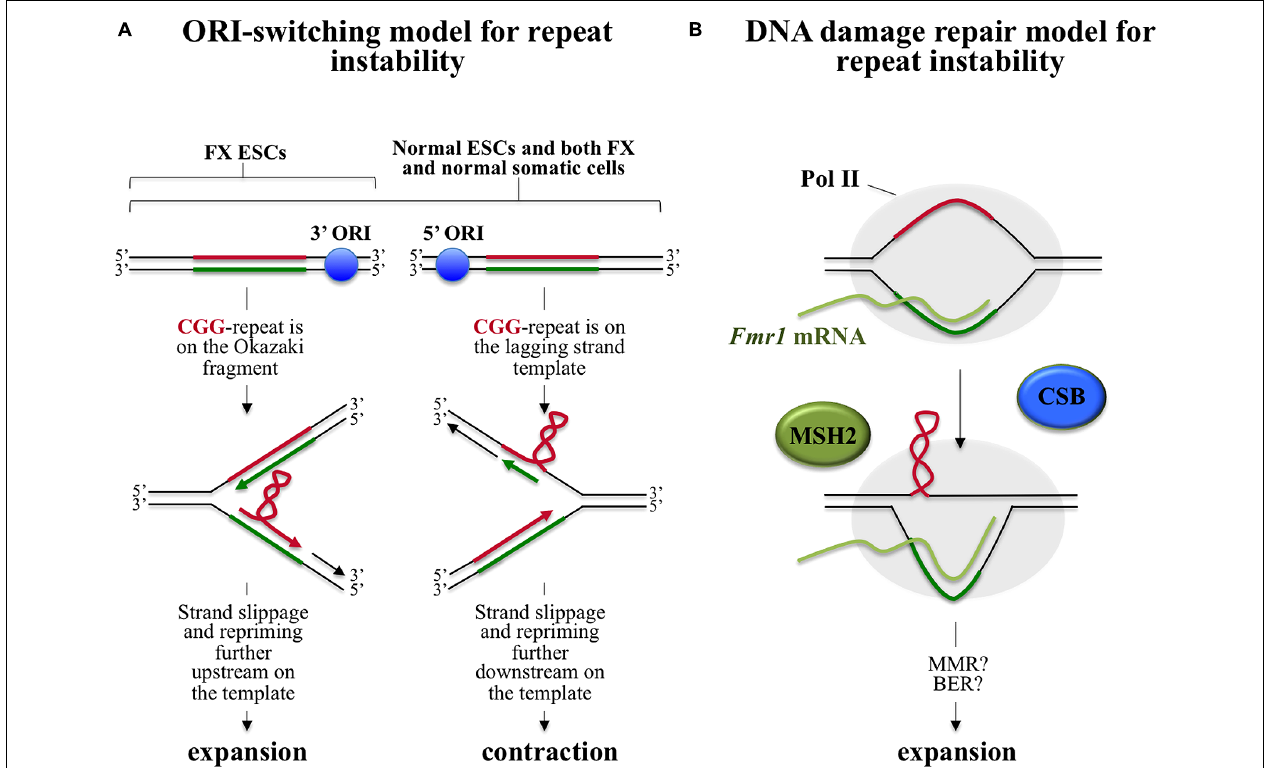
FIGURE 1 | Models for intergenerational repeat instability at the FX locus. In both models the CGG-rich strand, which forms the most stable secondary structure, is shown in red and the CCG-rich strand is shown in green. (A) ORI-switch model for FX repeat instability. The FMR1 gene is flanked by two ORIs, one located 45 kb upstream (5 (cid:2) ) and another 45 kb downstream (3 (cid:2) ) of the gene (Gerhardt etal., 2014). During replication transient dissociation of the Watson and Crick strands of DNA can occur with slippage of the two strands relative to one another. Priming of DNA synthesis can then occur from the slipped position. This strand-slippage process is thought to occur more commonly during lagging strand replication and is seen more frequently when the template or nascent strand have the potential to form secondary structures. Secondary structure formation by the lagging strand template would result in loss of repeats/contractions since repriming 5 (cid:2) of the structure on the template would be favored, while the formation of such structures on the corresponding Okazaki fragment would favor addition of repeats since repriming would then be more likely to occur more 3 (cid:2) on the template. Replication from the upstream ORI results in the CGG-rich strand being on the lagging strand template (note that only one side of the bidirectional